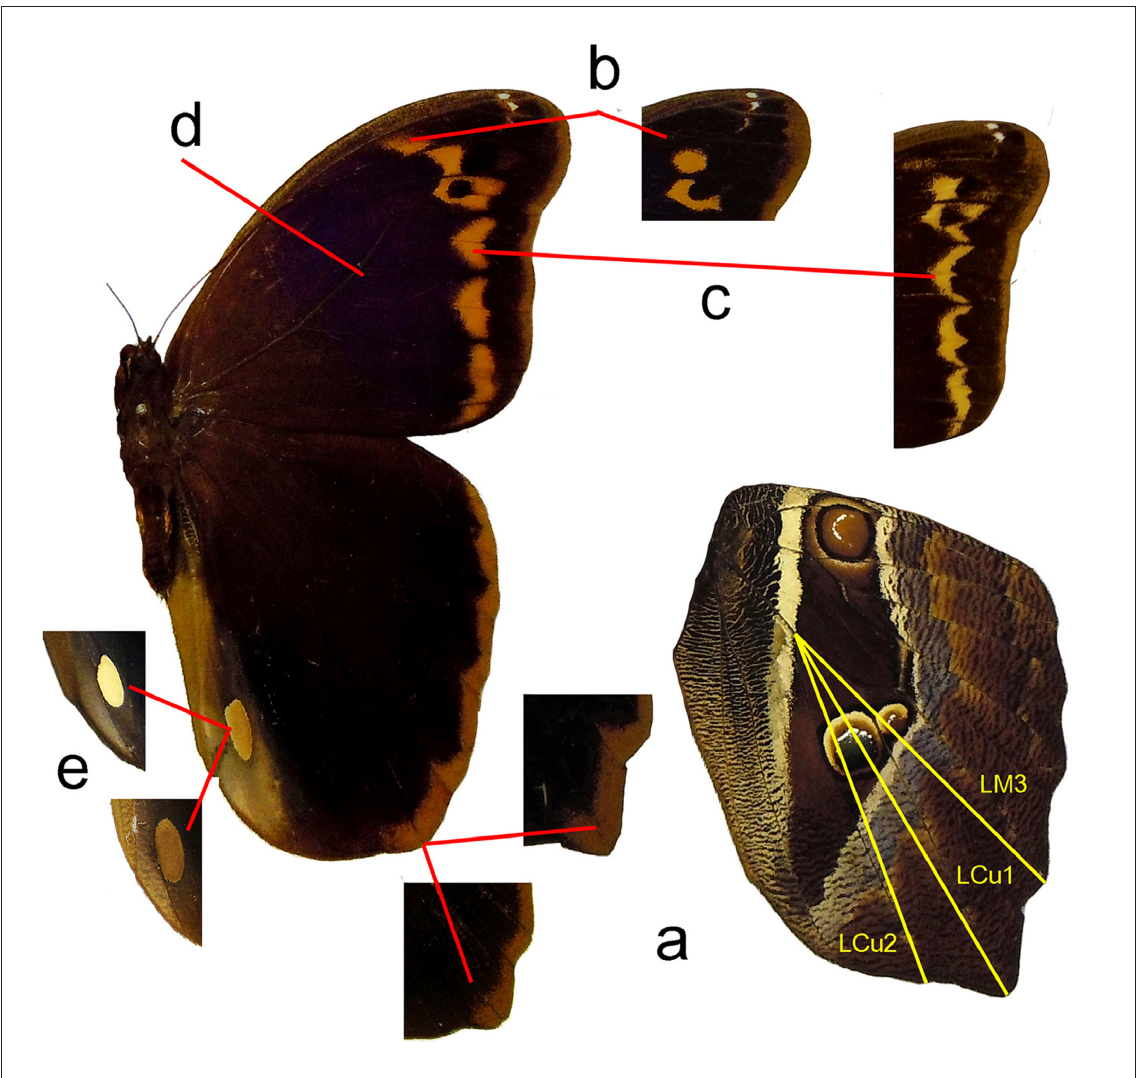
Fig. 1. Characters studied on the habitus (recto) and their major variations. a . HW projection, estimated by P = LCu1-((LM3+LCu2)/2) in milimetres). b . Orange mark between veins R5-M1. c . Size and shape of the orange marks. d . Violet-blue iridescence. e . Male androconial